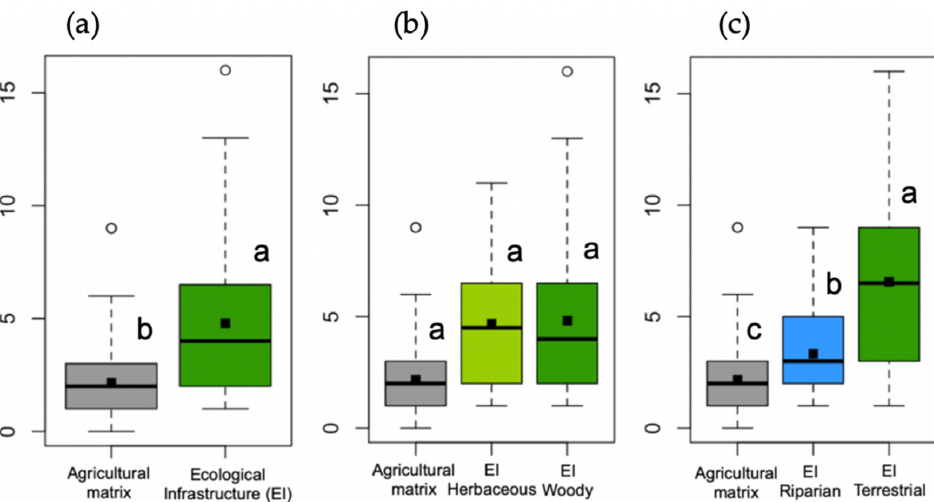
Figure 2. Boxplots represent the ant species richness among groups. ( a ) Ecological infrastructures (EI) vs. agricultural matrices; ( b ) woody EI vs. herbaceous EI vs. agricultural matrices; ( c ) terrestrial EI vs. riparian EI vs. agricultural matrices. Different letters show significant differences between and among groups (Tukey’s HSD test).